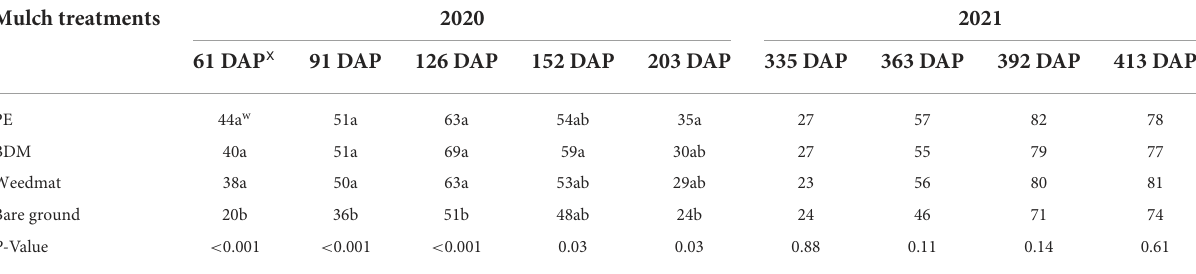
TABLE 2 Strawberry cv. Albion canopy cover z (%) when grown on raised beds with polyethylene (PE), soil-biodegradable mulch (BDM), weedmat, or bare ground treatments in a Mediterranean climate, May 2020 to July 2021 y . Mulch